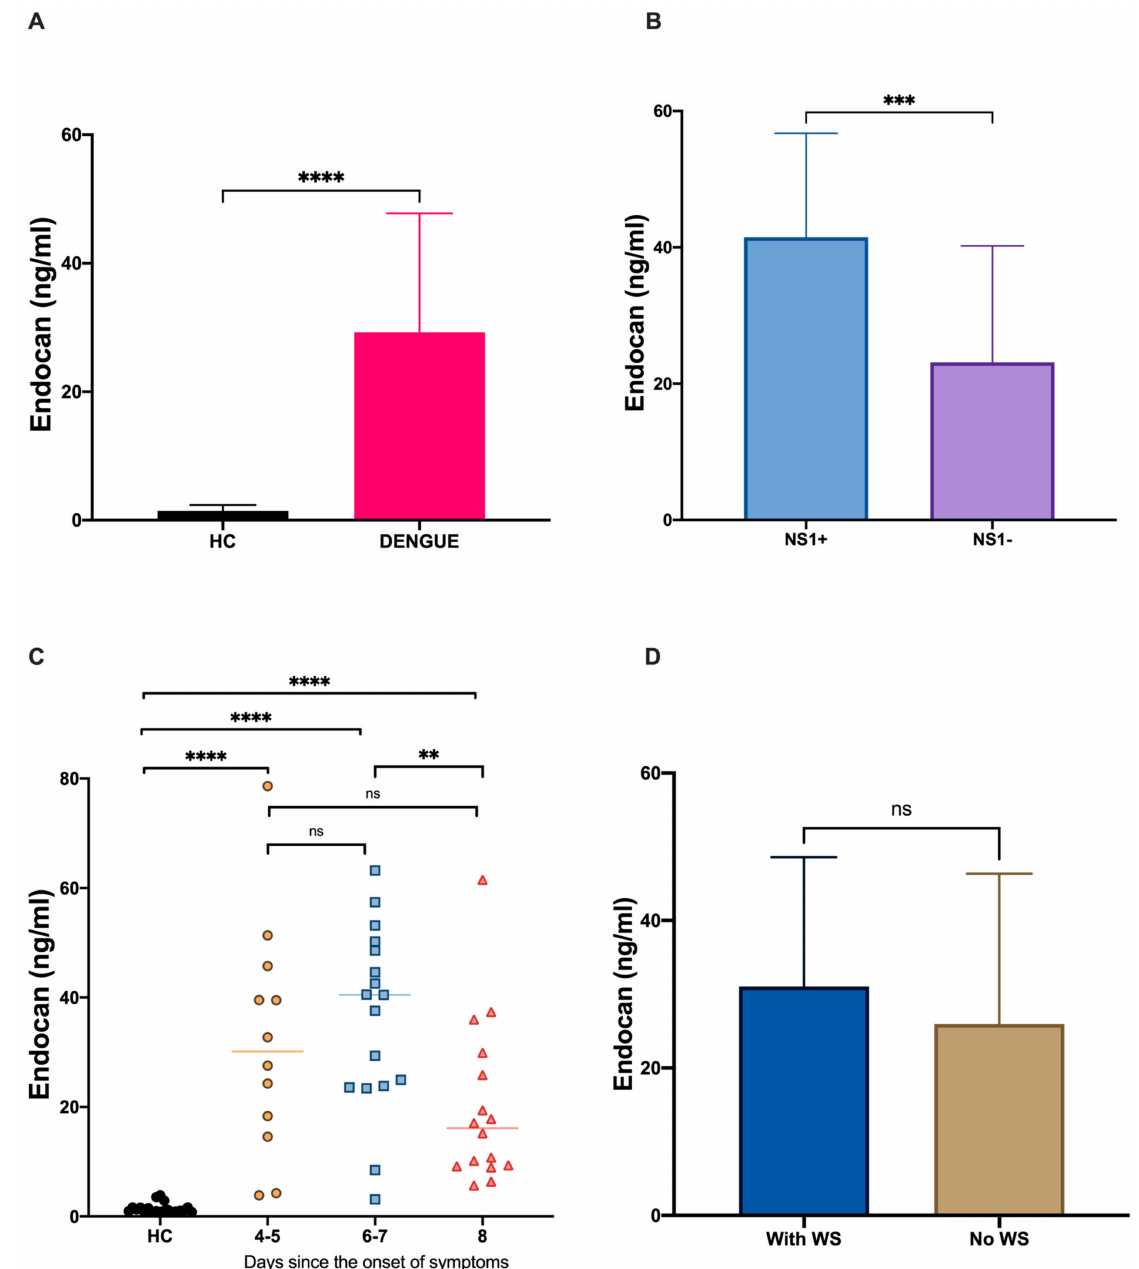
Figure 2. Endocan levels in patients with dengue infection. The serum levels of endocan were evaluated in healthy controls (HC) ( n = 20) and dengue patients ( A ) ( n = 45). Dengue patients were classified as positive ( n = 15) or negative ( n = 30) for the NS1 antigen ( B ) and were categorized by days after the onset of symptoms ( C ) and as dengue with (With WS) ( n = 29) or without warning signs (No WS) ( n = 16) according to the WHO 2009 dengue classification ( D ). The endocan levels were compared in all groups. Data were analyzed using Mann–Whitney’s U test. ** p < 0.01, *** p < 0.001, **** p < 0.0001, ns: not